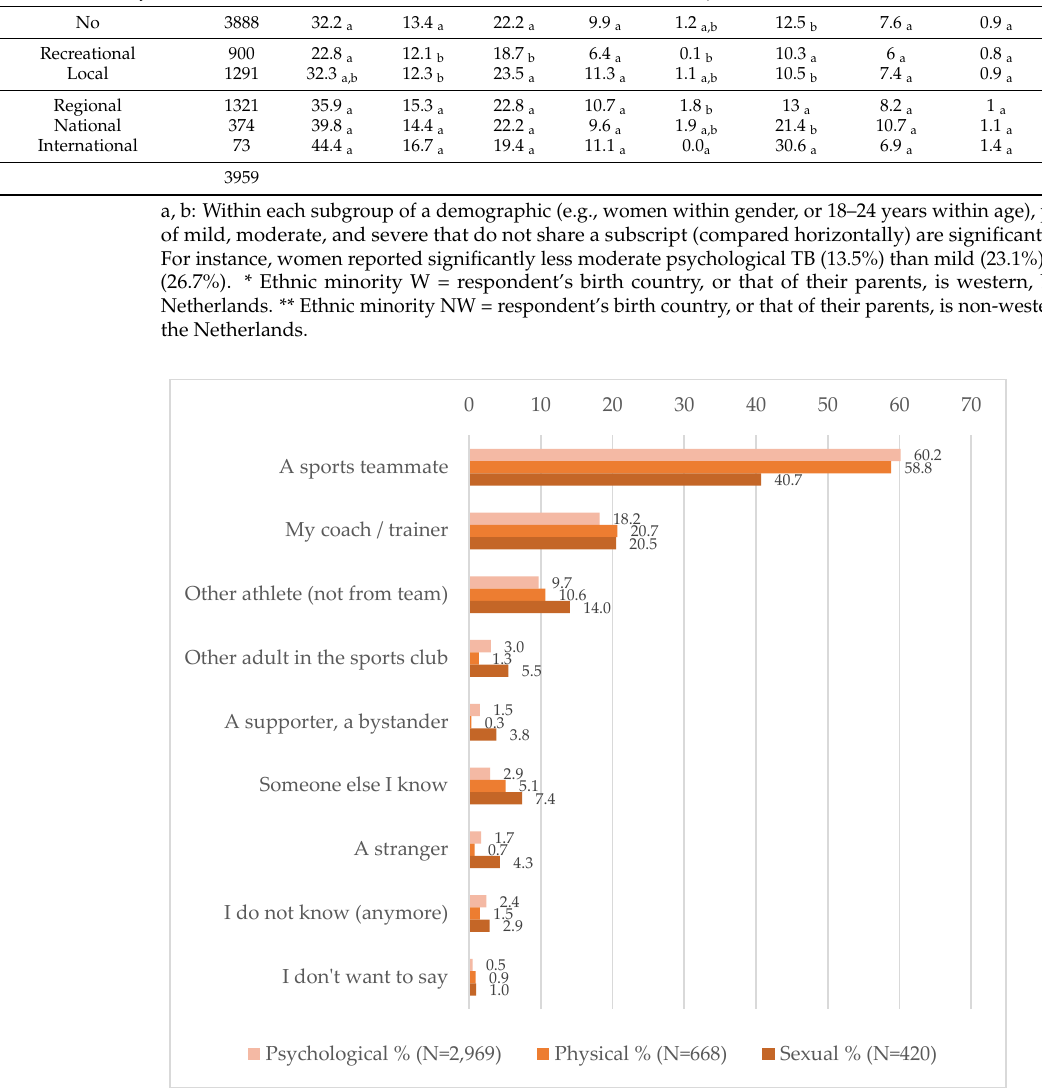
Figure 2. Relationship to the offender.